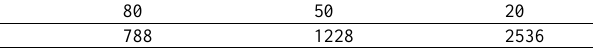
Table 15. Parameters of the cumulative load demand curve (Examples 3 and 4). Demand level ( % )